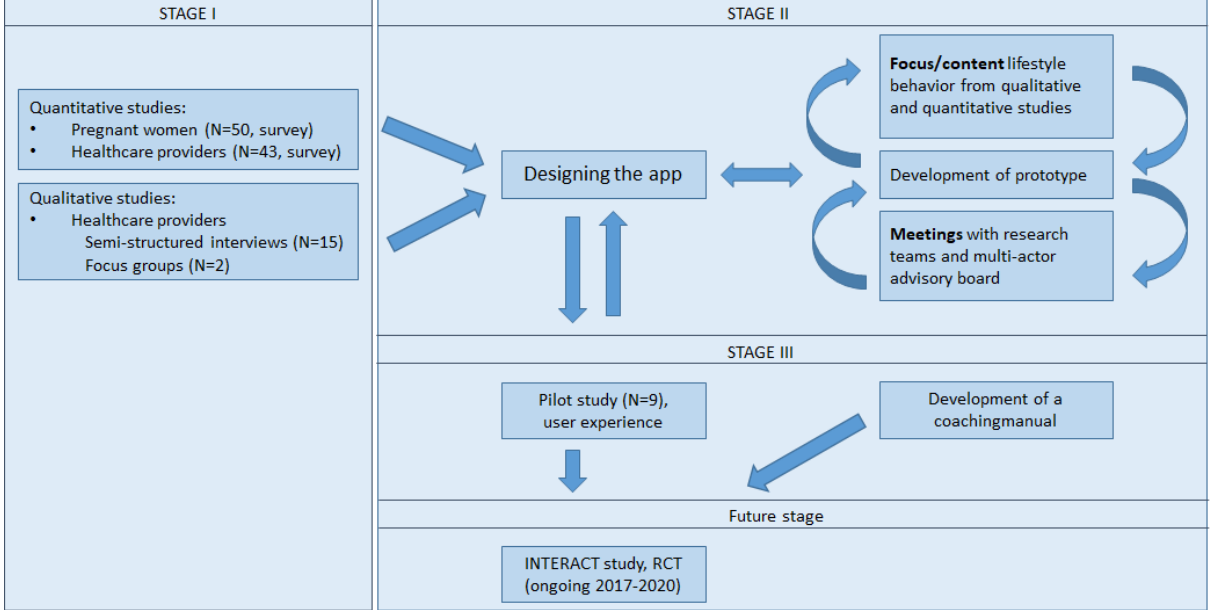
Figure 1. Flow chart of the three stages of app development (data collection, app development, and field evaluation). RCT: randomized controlled trial.